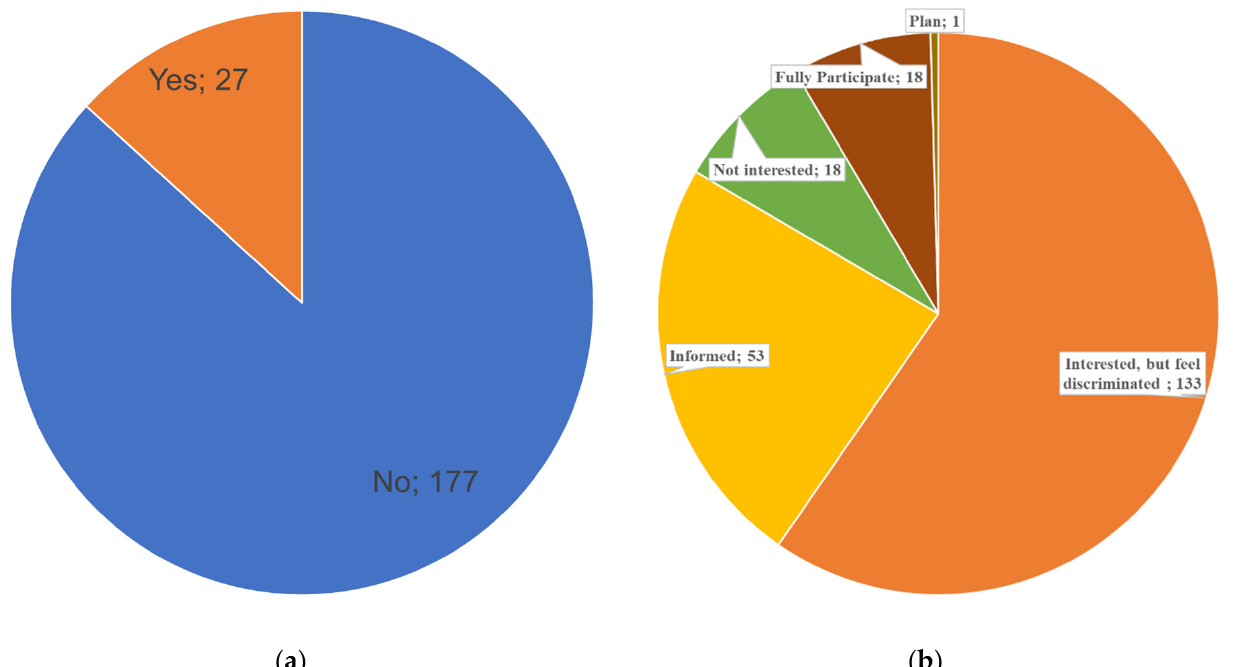
Figure 11. Organizational membership and role in community matters. Membership of respondent in a community-based organization ( a ). Preference for and inclusion in community meetings and decision-making (b). Source: Fieldwork.